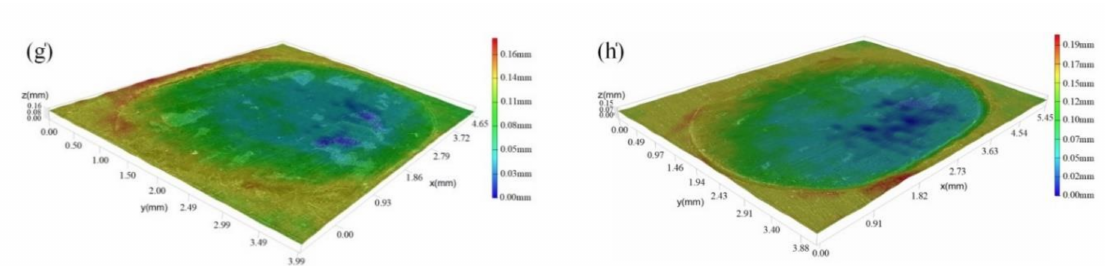
Figure 3. SEM images and 3D optical morphologies of worn surfaces. ( a , a’ ) PEEK, ( b , b’ ) PG03, ( c , c’ ) PG07, ( d , d’ ) PG1, ( e , e’ ) PM5, ( f , f‘ ) PM15, ( g , g’ ) PM25, ( h , h’ )